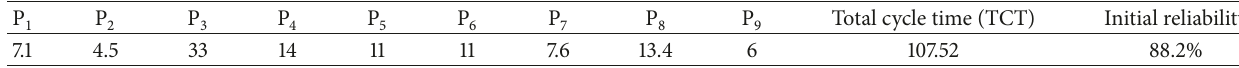
Table 2: Initial design variables.